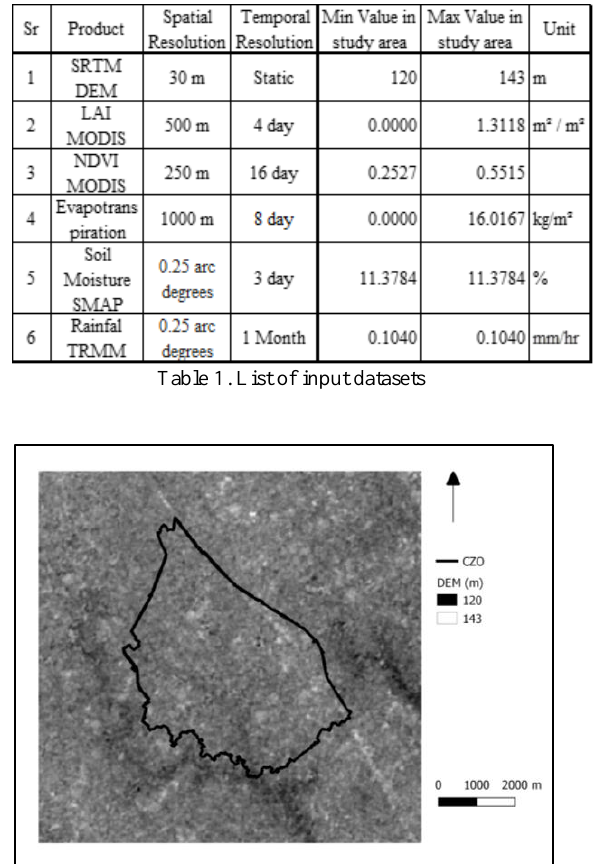
Figure 2.1. Digital Elevation Model